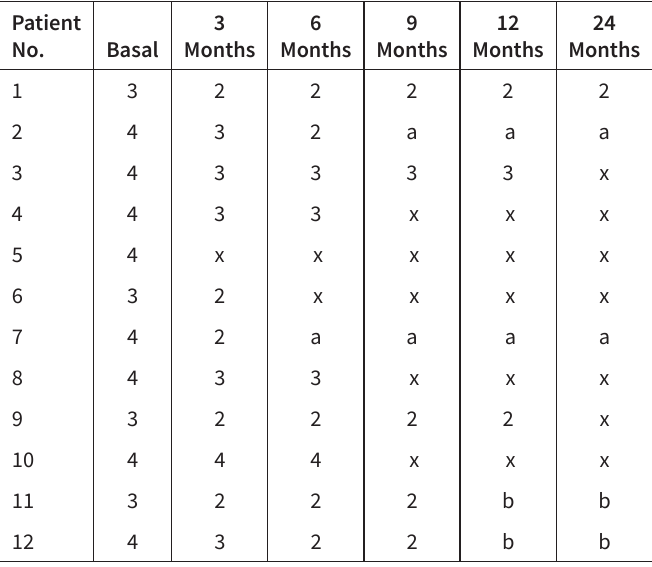
Table 5. Change in Functional Capacity According to New York Heart Association (NYHA)